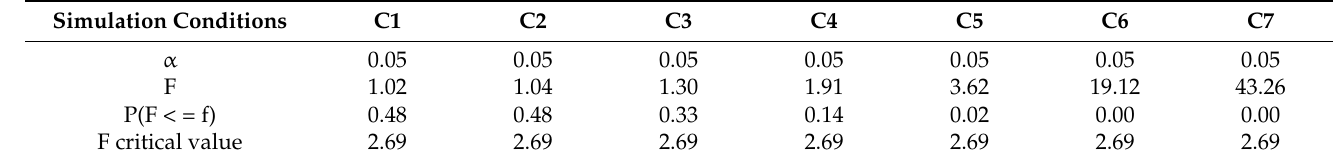
Table 5. F-test of two vertical coordinate models with different bottom